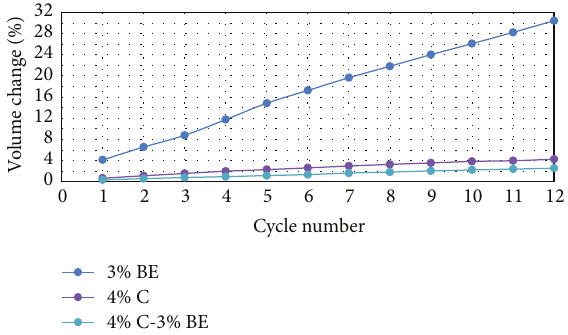
Figure 8: Results of MSR and TSR for various additives.